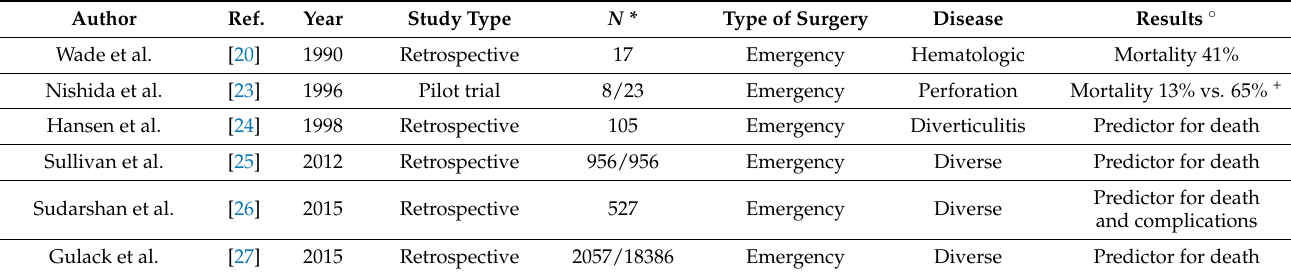
Figure 1. Flowchart of search process. Table 2. Overview of included studies.